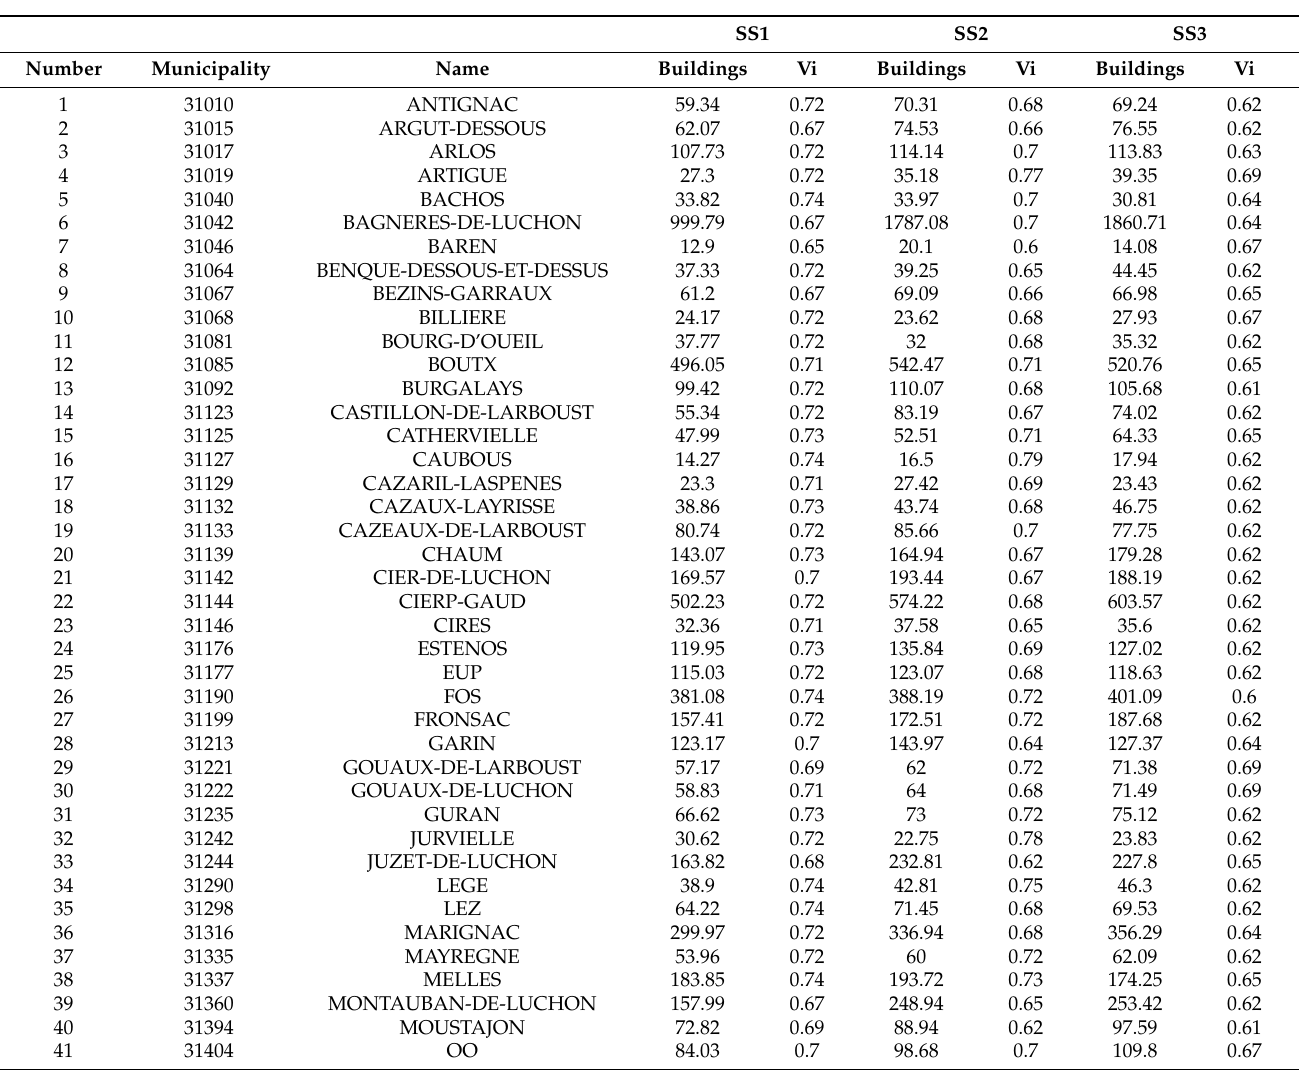
Table 5. Building exposure data (number of buildings and the average vulnerability index) by municipality in the Luchon area, extracted from the three databases used for this study.